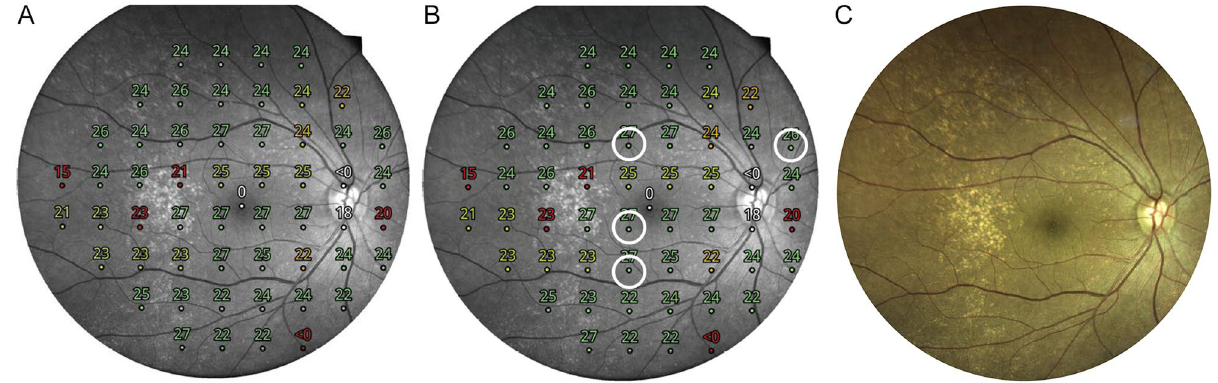
Figure 1. Measurement of retinal sensitivity using microperimetry. Retinal sensitivity (decibels [dB]) for each of the 52 areas was measured using the compass fundus microperimeter. ( A ) Composited images of topographical information on retinal sensitivity and red free fundus photographs were obtained. ( B ) Areas unoccupied by drusen were identified manually in composited images. ( C ) A color fundus photograph was used to confirm the area occupied by drusen.